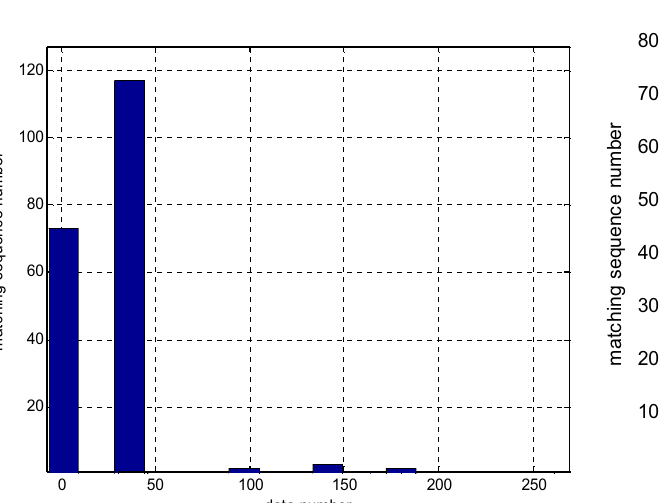
Figure 9: Identi fi cation results of matching sequence number fre - quency statistics based on fuzzy relative entropy.